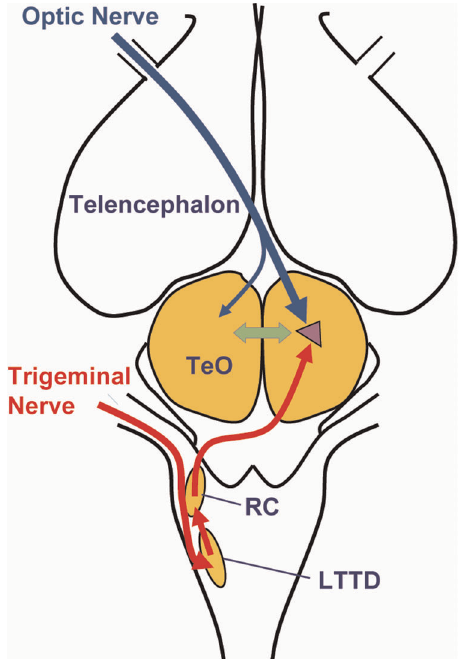
Figure 3. Schematic diagram of the two imaging sensory circuits. Schematic diagram of the snake brain (anterior is up and posterior is down) illustrating visual (blue) and IR (red) pathways showing convergence of visual (blue) and IR (red) inputs in the contralateral tectum. Abbreviations: LTTD, nucleus of the lateral descending trigeminal tract; RC, nucleus reticularis caloris; TeO, optic tectum. The arrow interconnecting the left and right optic tectums represents the tectal commissure and the filled triangle in the tecta represents the tectal bimodal neuronal population (see text).